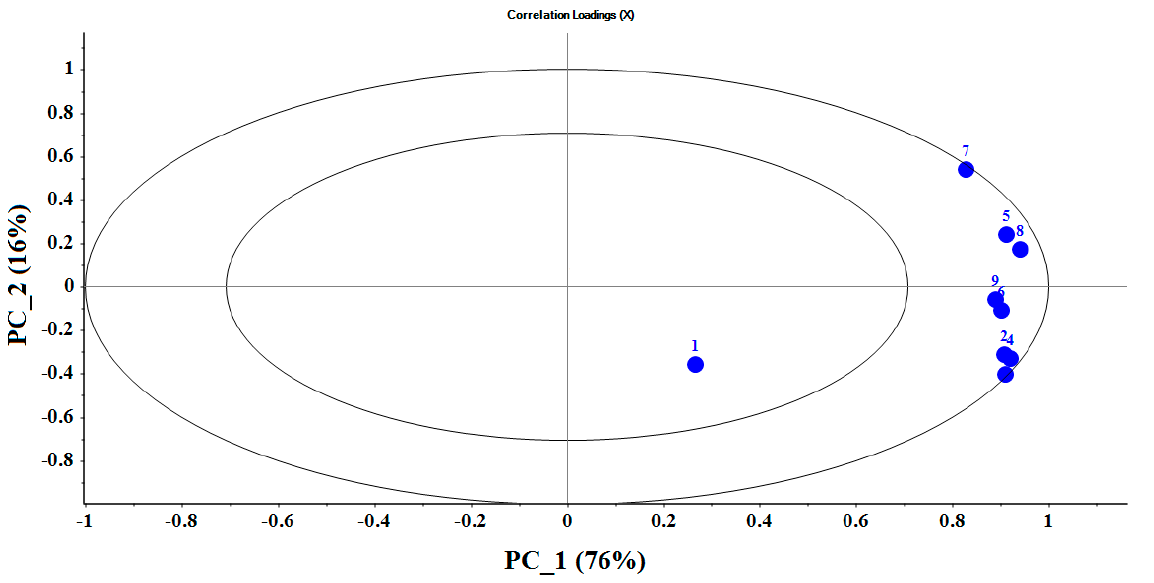
Figure 6. Loading plot for PCA analysis to identify five different potato cultivars. Abbreviations: (1) MQ9, (2) MQ4, (3) MQ135, (4) MQ8, (5) TGS2620, (6) MQ136, (7) TGS813, (8) TGS822, and (9) MQ3.